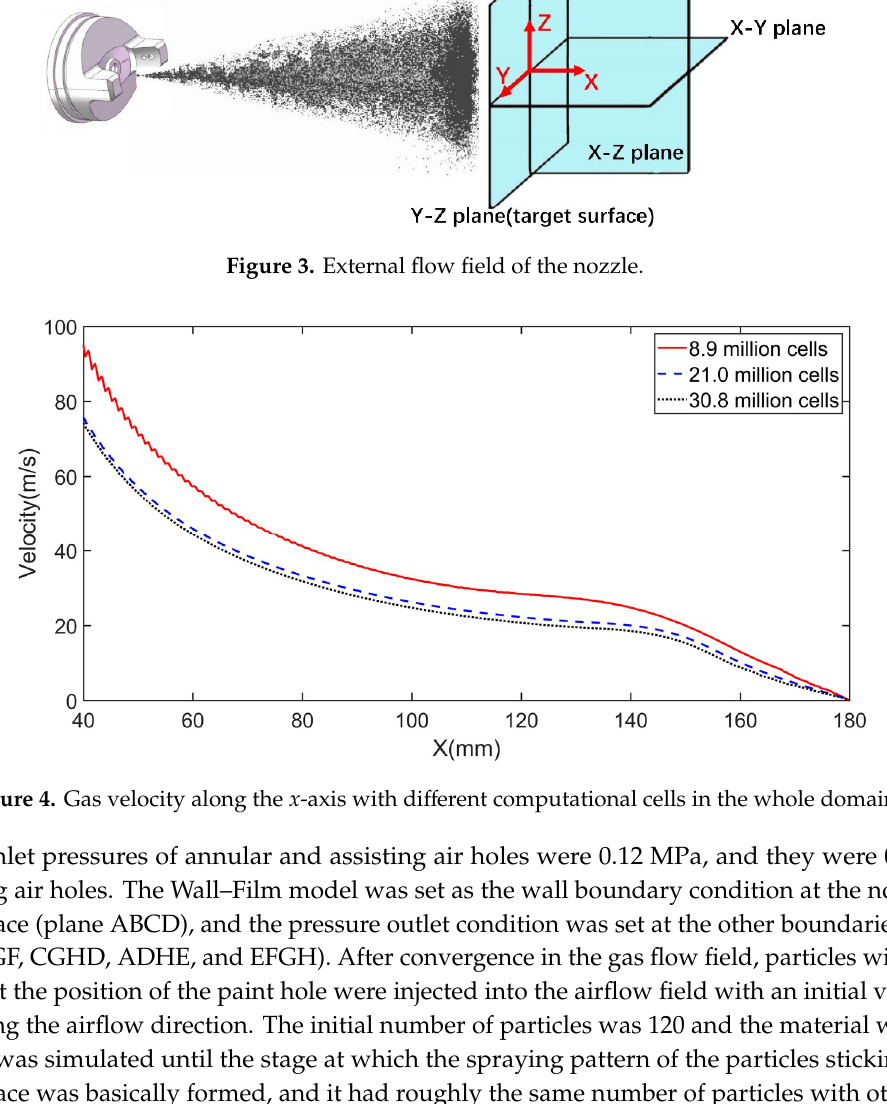
Figure 2. Mesh of the computational domain.